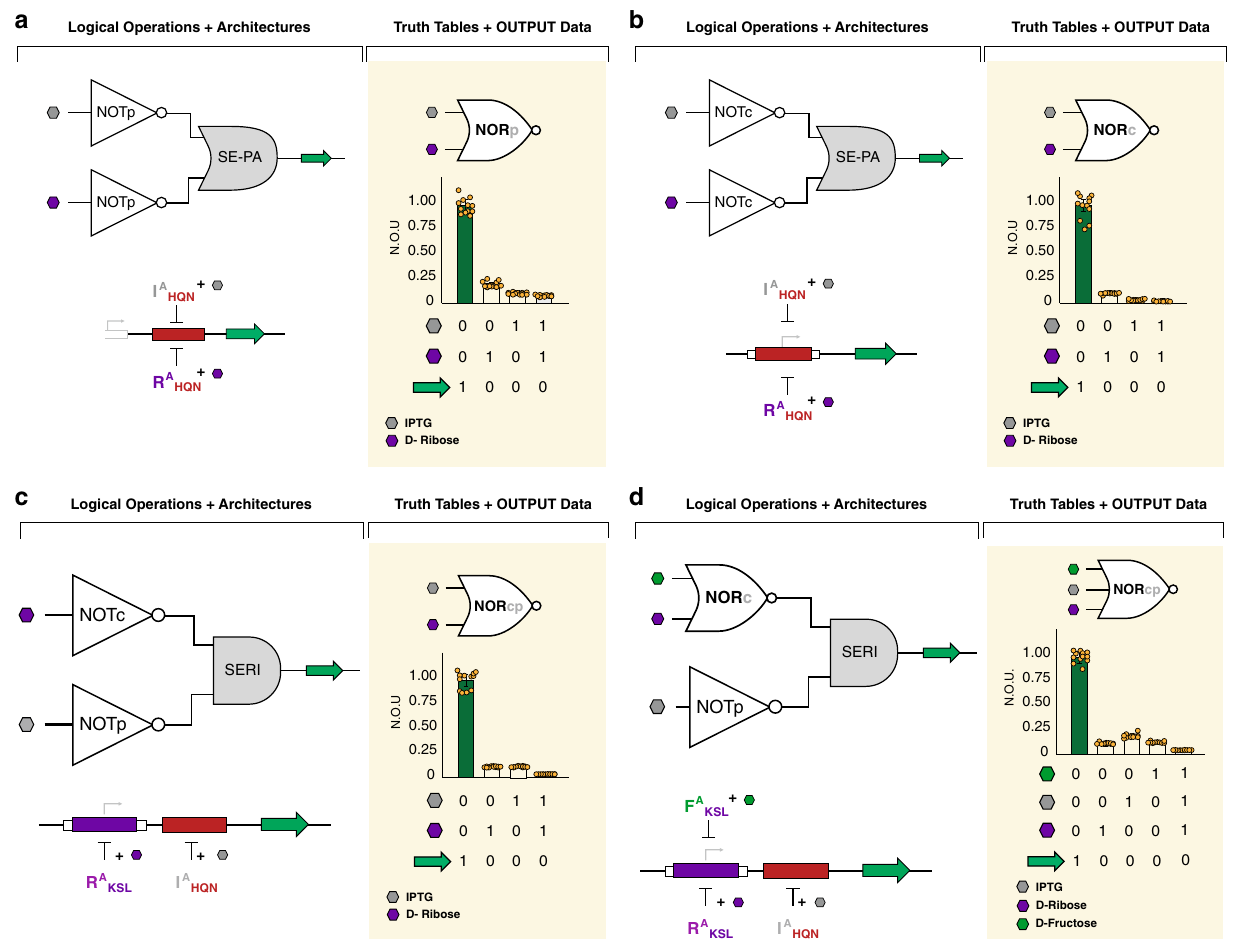
Fig. 7 Transcriptional NOR logic gates. NOR gates may be constructed using combinations of NOT operations in either series-parallel (SE-PA) ( a , b ) or series (SERI) ( c , d ) genetic architectures. In plots, vertical-bars display normalized output units (N.O.U.), the standardized mean (de fi ning the measure of centre) fl uorescence intensity as a fraction of the maximum observed for that operation ±1 S.D., and truth tables are shown, below, corresponding to bars, above, for different ligand conditions. Results shown are from n = 12 independent biological replicates with similar results, dots shown for each replicate. a NORp gates were constructed from two NOTp operations in SE-PA. R A(1) HQN and I A(5) HQN (from Rondon and Wilson 44 ) both regulated GFP via a proximal O ttg operator. In the presence of either, or both, ligands, IPTG and D-ribose, transcription was anti-induced, causing diminished gene expression. b By moving the O ttg operator to the core position, a NORc gate was constructed from two NOTc operations. c A NORcp gate was constructed from two NOT operations in series — NOTc and NOTp. Here, R A(1) KSL regulated a core O agg operator and I A(5) independently regulated a proximal O ttg operator, both upstream of the GFP reporter gene. Only in the presence of neither ligand was gene transcription unabated. d A three-input NORcp gate was constructed by the addition of the F A(2) KSL transcription factor, which additionally regulated the core O agg operator. Now, the presence of any of the three ligands, IPTG, D-ribose, and fructose, was suf fi cient to inhibit gene